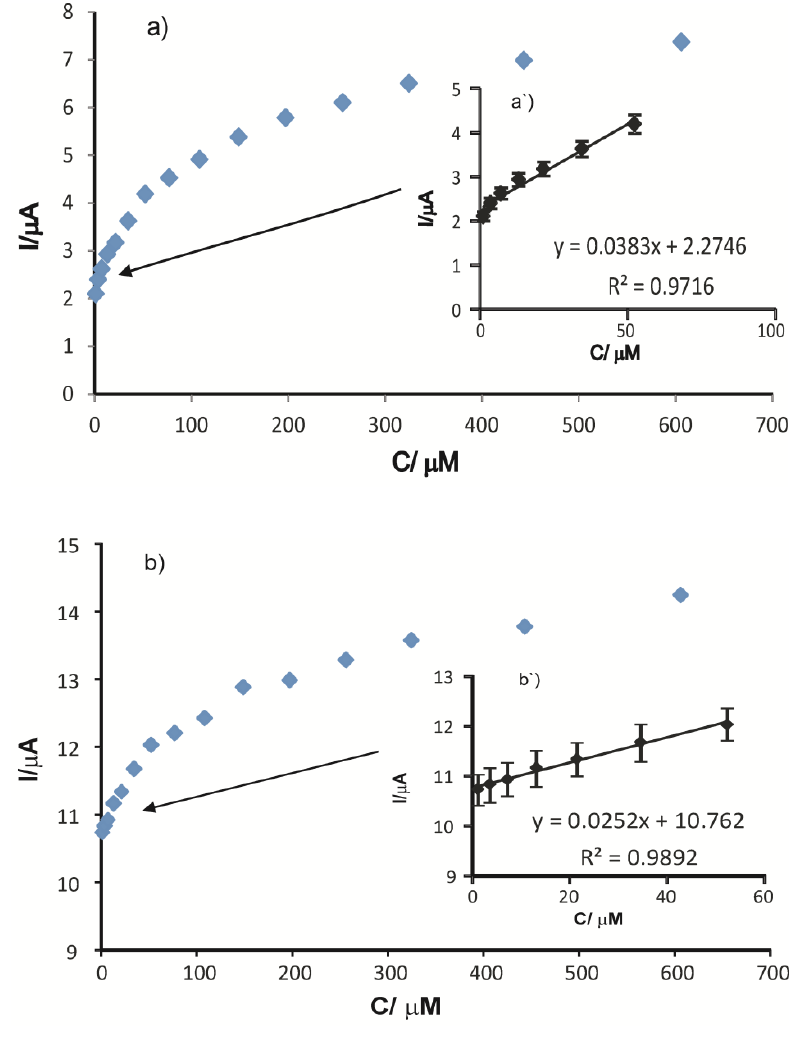
Figure 7. The linear fitting between I pa and the atorvastatin concentration for ( a ) SPCE and ( b ) AuNP-CNT/SPCE in the 1.2–606.25 µM concentration range. The inserted figures present the linear dependence between I pa and c for (a’) SPCE and (b’) AuNP-CNT/SPCE in the 1.2–53.33 µM concentration range. Error bars are represented for a standard error of 5%.